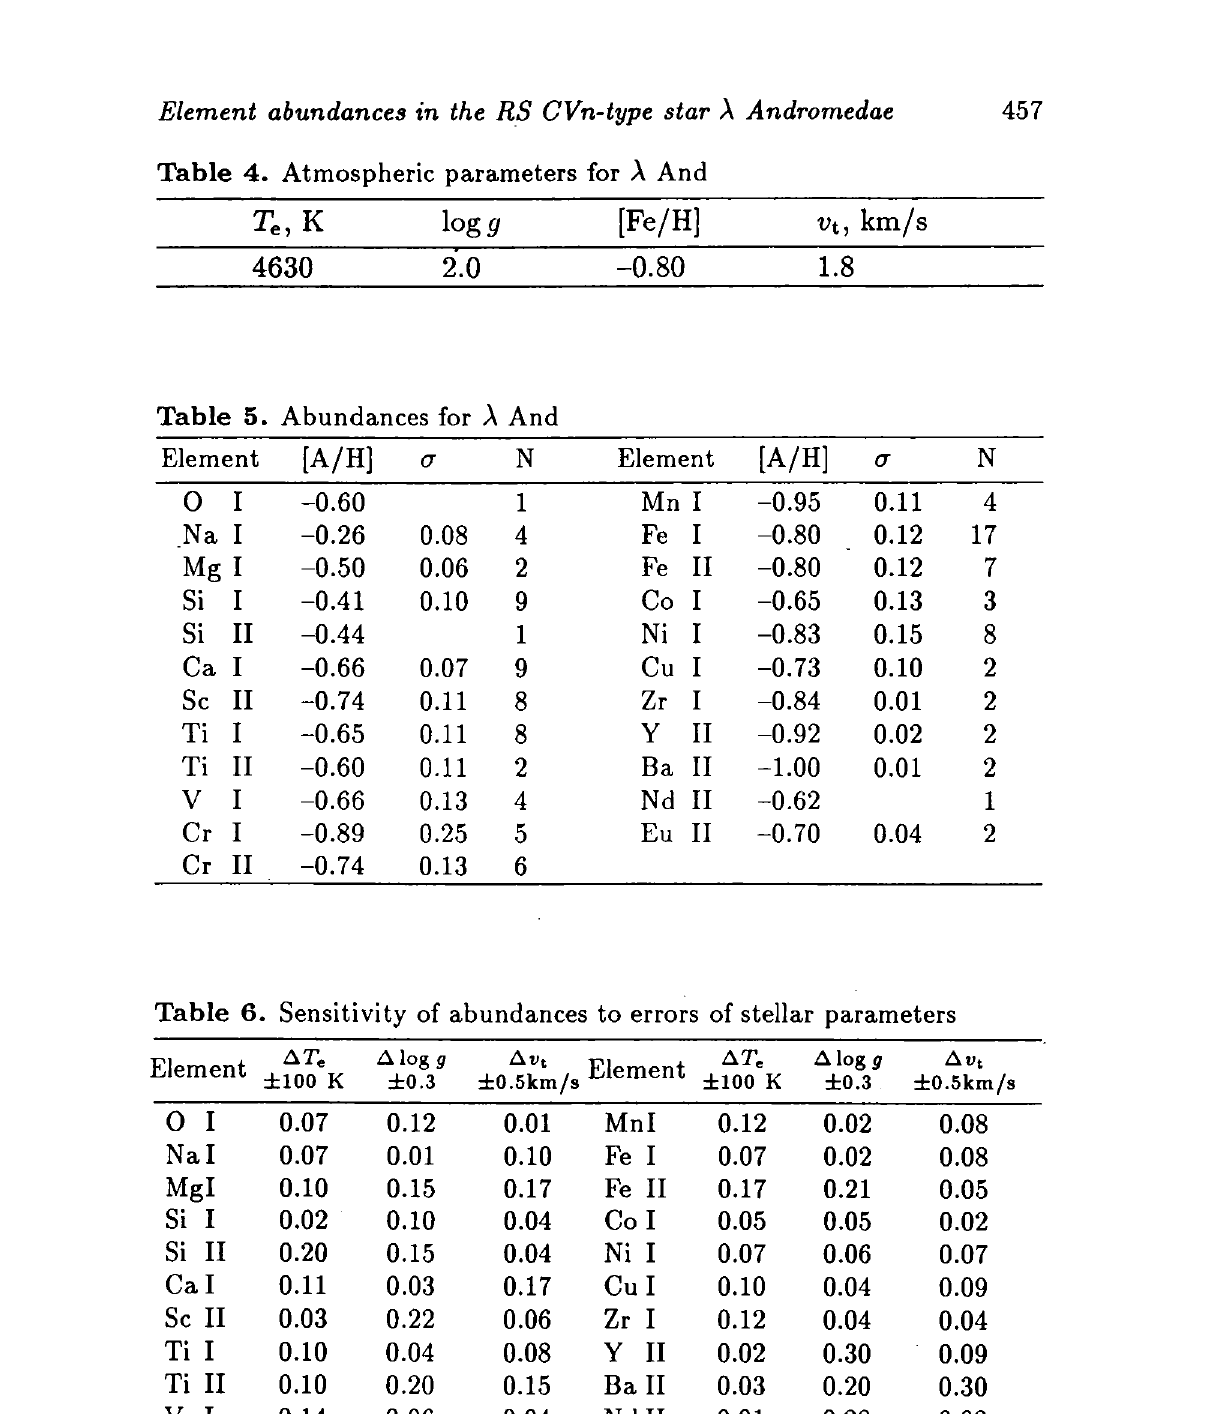
Table 6. Sensitivity of abundances to errors of stellar